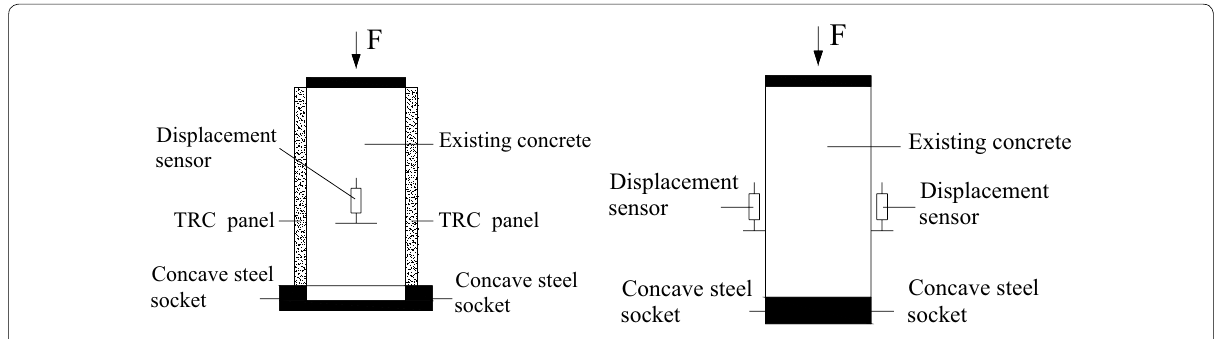
Fig. 2 Schematic diagram of double shear